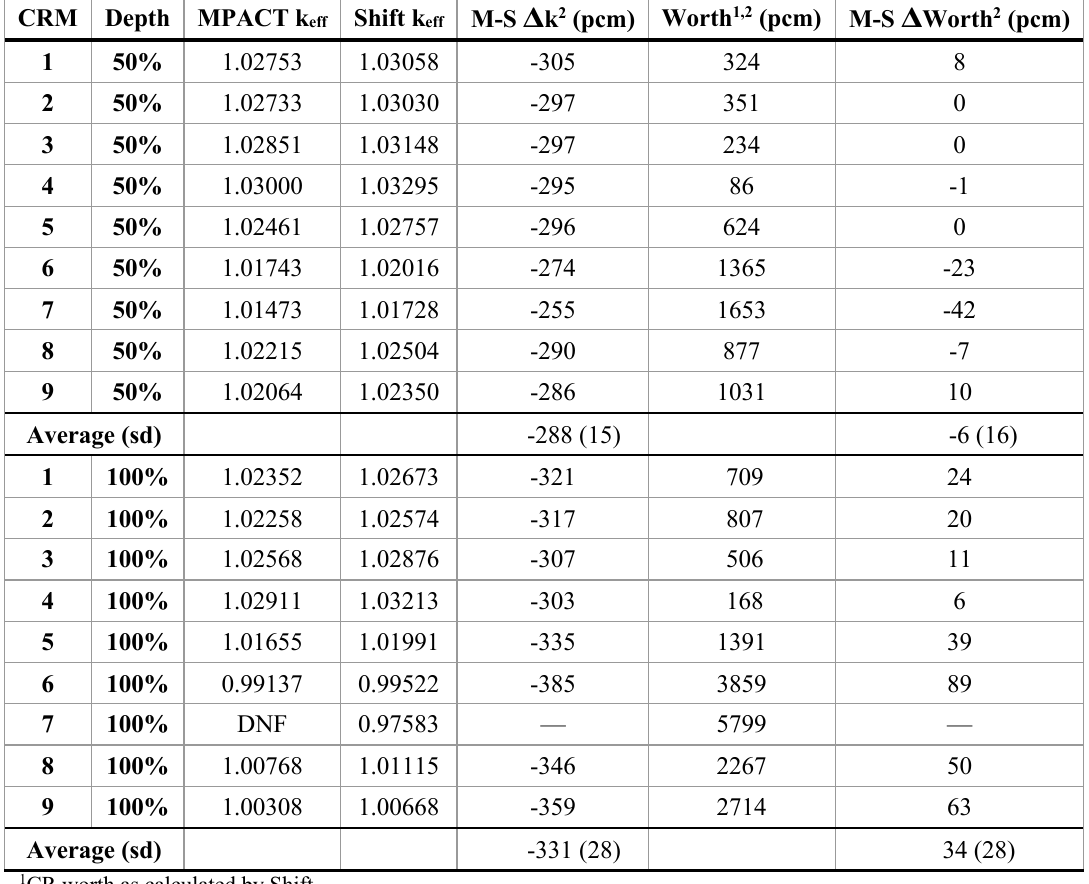
results and rod eff